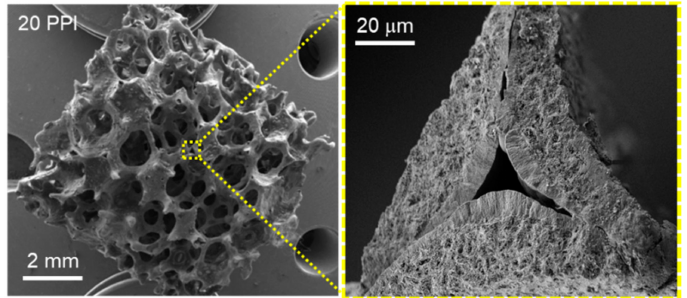
Figure 1. ( Left ) SEM micrograph of the SiC foam (20 PPI, ~0.06 cm 3 ) and ( Right ) micrograph of a